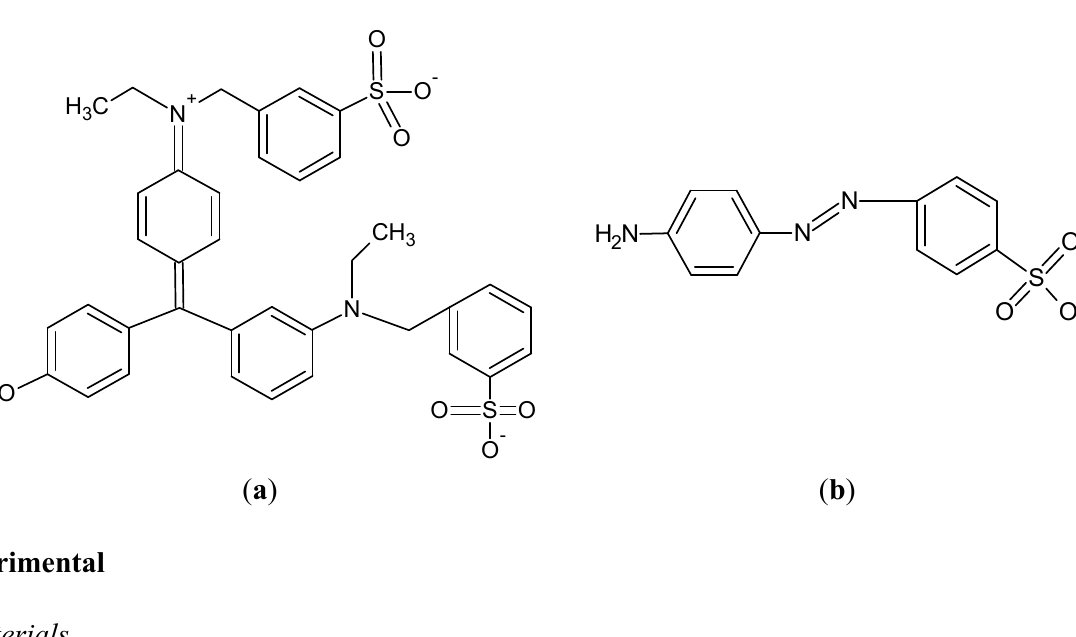
Figure 10. ( a ) Methylene orange and ( b ) Fast green chemical